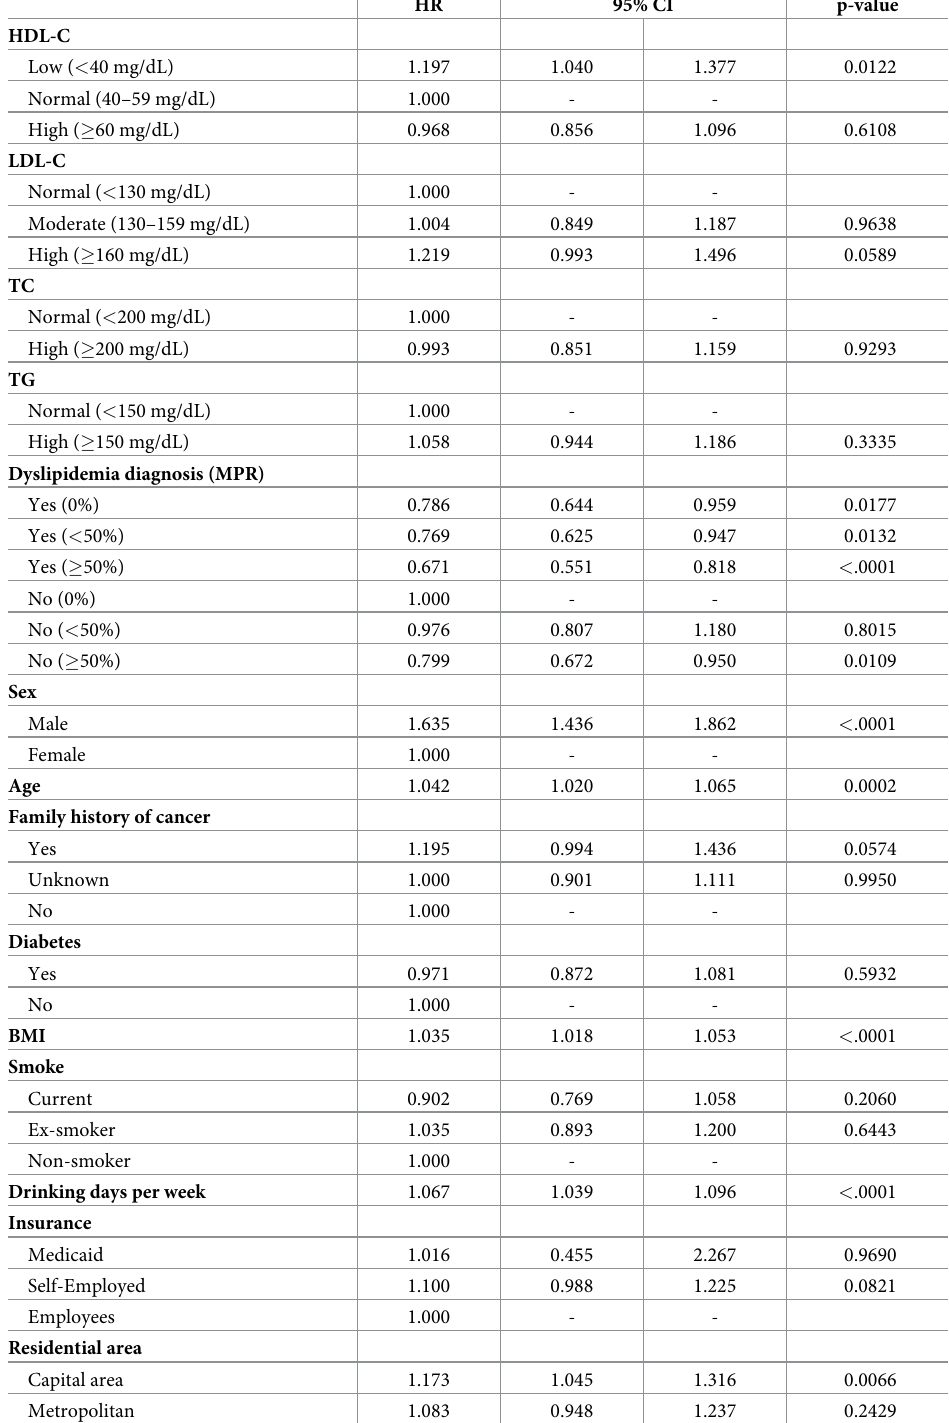
Table 2. The association between serum cholesterol levels and colorectal